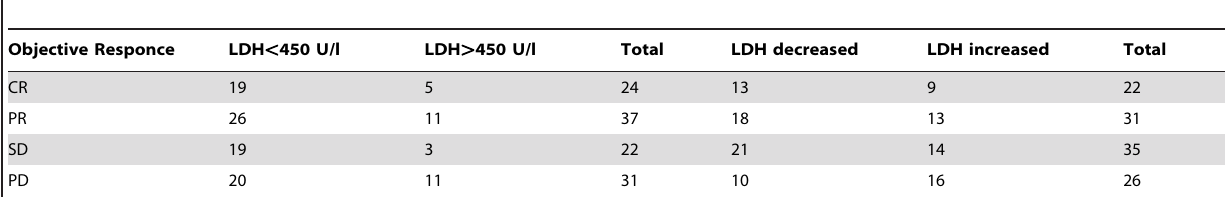
Table 2. Objective response evaluated with RECIST criteria (New Response Evaluation Criteria in Solid Tumors 1.1), no statistically significant difference was found between the groups of patients analyzed: lactic dehydrogenase (LDH) major or minor of 450 U/l and LDH decreased or increased after